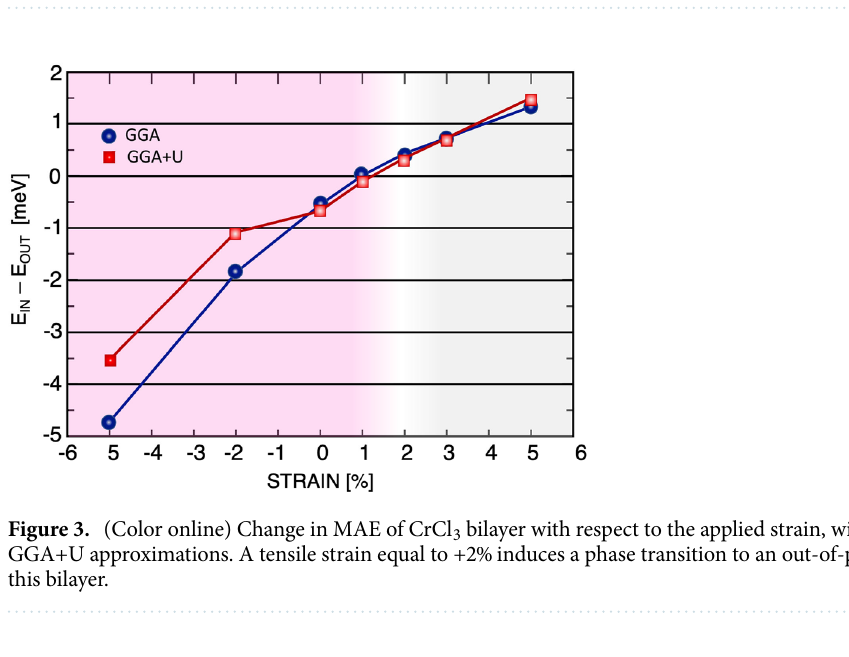
Figure 2. (Color online) The energy difference between the FM and AFM phases for CrCl 3 as a function of strain. The results of GGA+U (GGA) calculation indicate that a magnetic phase transition from FM to G-type AFM can occur under a compressive strain larger than 3(1) % .